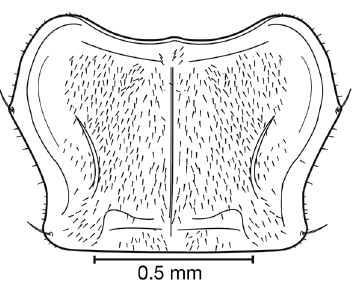
Figure 98. Line drawing, dorsal view, showing form and setae pattern of the pronotum of Mochtherus obscurabasis sp.